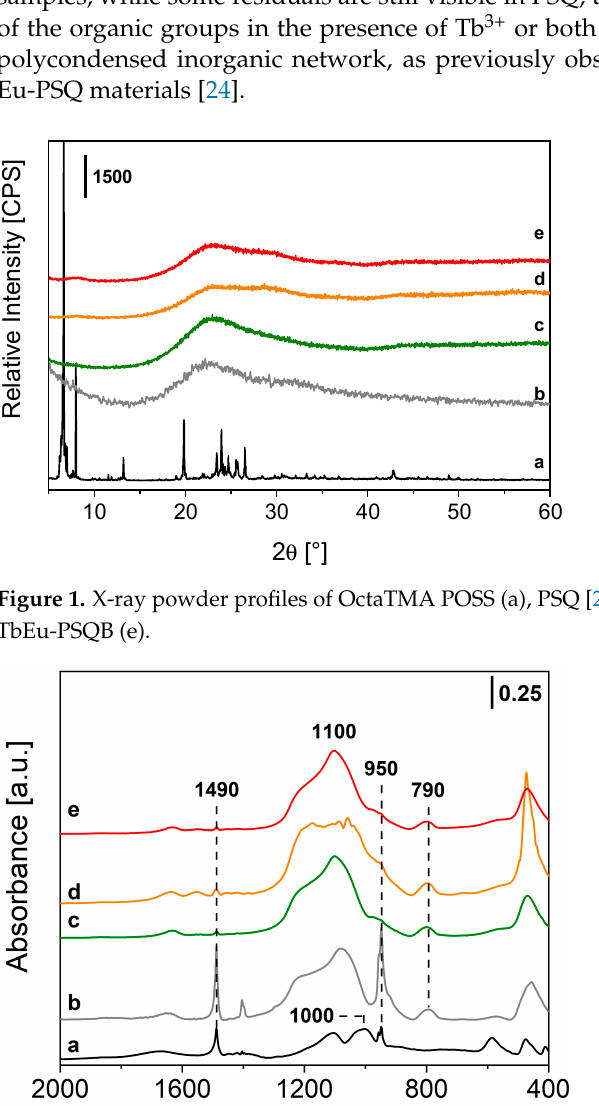
Figure 1. X-ray powder profiles of OctaTMA POSS (a), PSQ [24] (b), Tb-PSQ (c), TbEu-PSQA (d) and TbEu-PSQB (e).